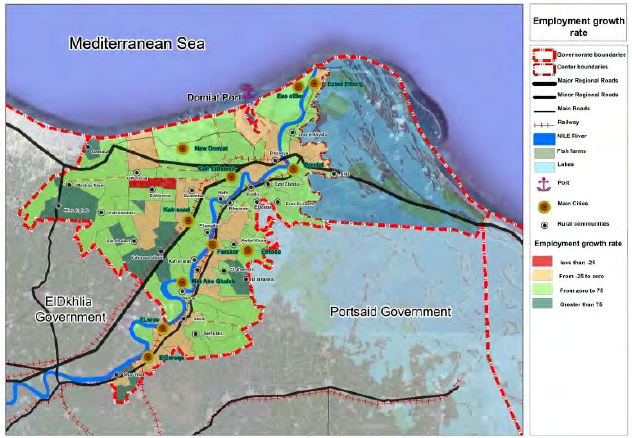
Figure 6. Growthof employment in the Damietta